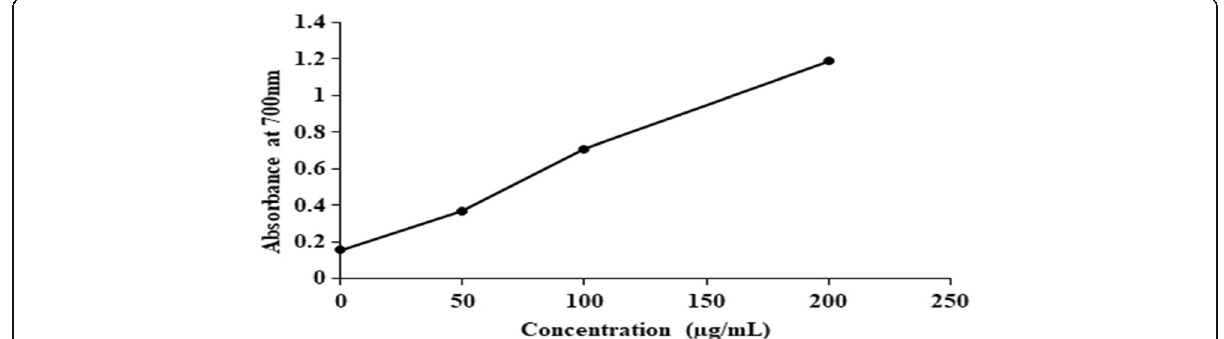
Fig. 3 A standard graph of total reducing power of standard vitamin C as a function of concentration ( μ g/mL) along x- axis and absorbance at 700 nm along y-axis